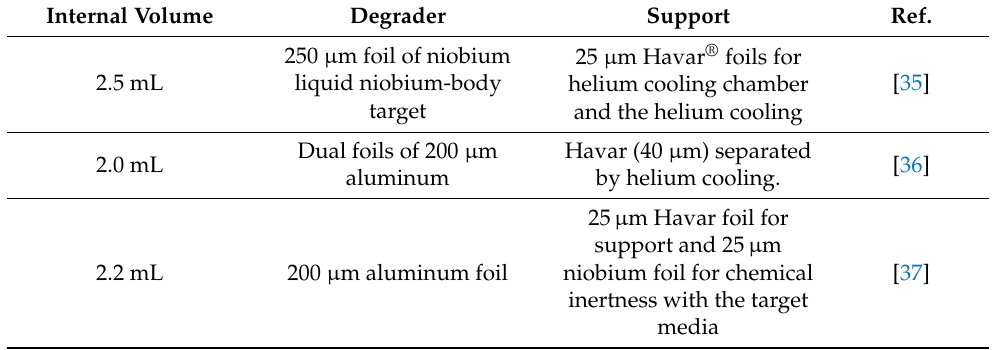
Table 5. Target preparation or